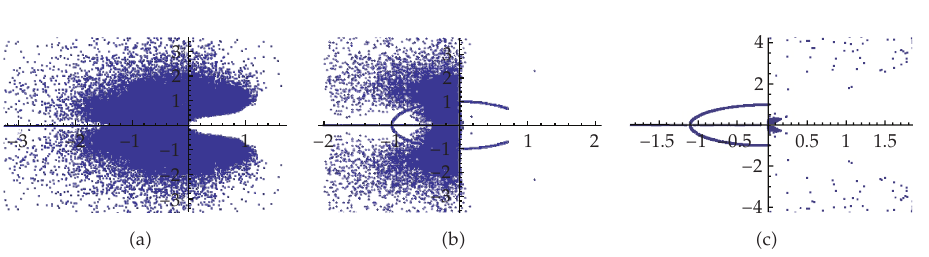
Figure 2: (cid:5) a (cid:6) The position, on the complex plane, of the zeros of 50000 random integer degree six polynomials with coe ffi cients between 0 and 1000. (cid:5) b (cid:6) The same, but with monic palindromic sextics. (cid:5) c (cid:6) Monic palindromic sextics, and with linear term